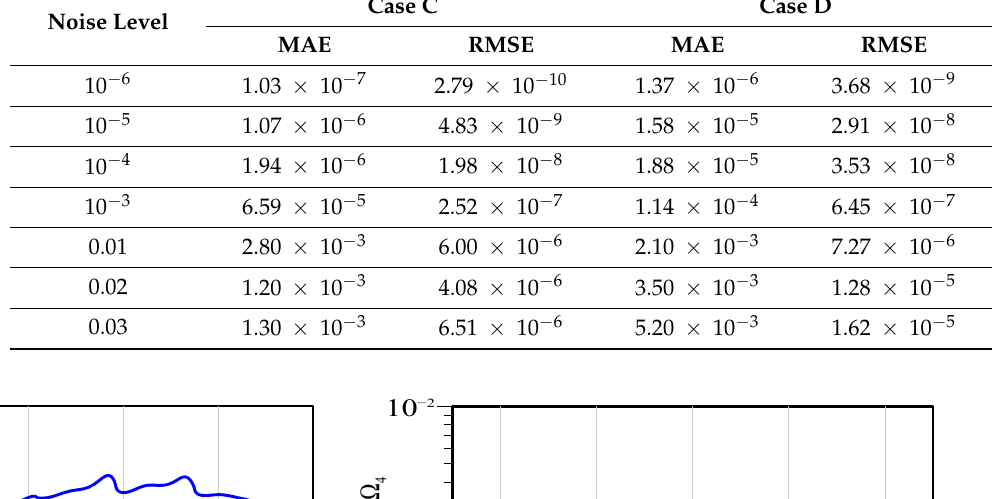
Table 3. Errors of the proposed method with various noise levels.